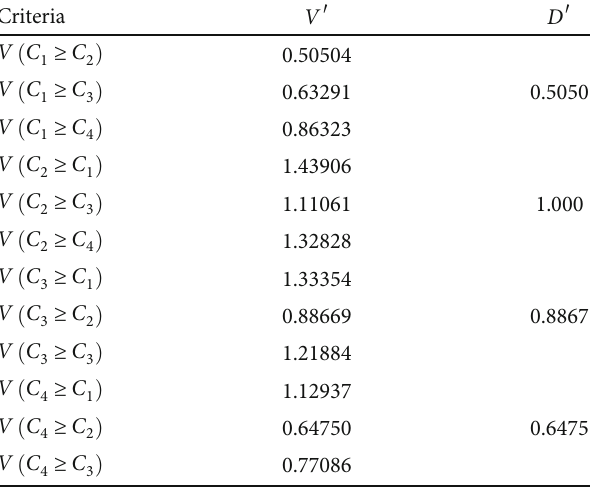
Table 11: Defuzzi fi cation of criteria.